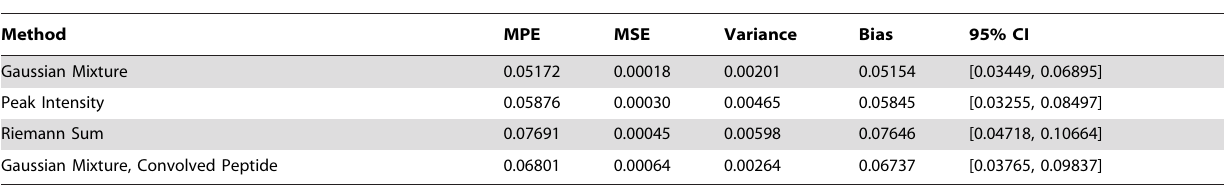
Table 1. Method Comparison Summary.